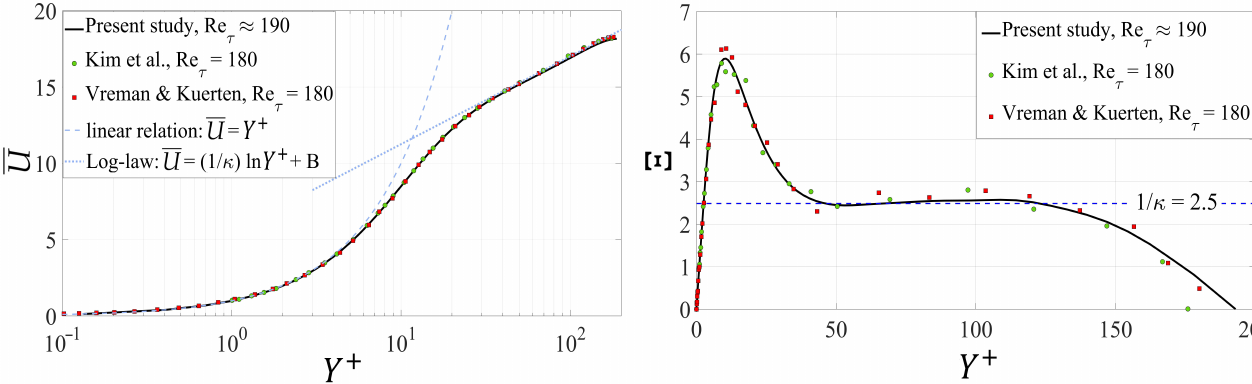
Figure 7. Behavior of the mean streamwise velocity, U , in different regions of the turbulent boundary layer: ( left ) mean velocity profile in wall coordinates; ( right ) the log-law diagnose function, Ξ . Results are only displayed over the lower half of the smooth